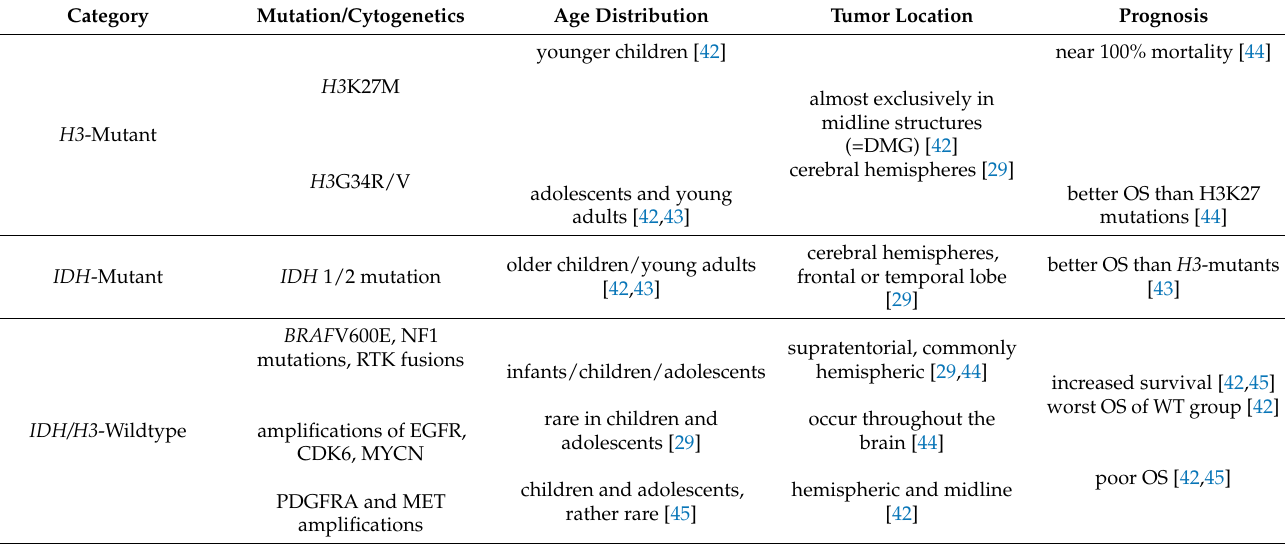
Table 1. Subdivision of pediatric GBM into three distinct molecular